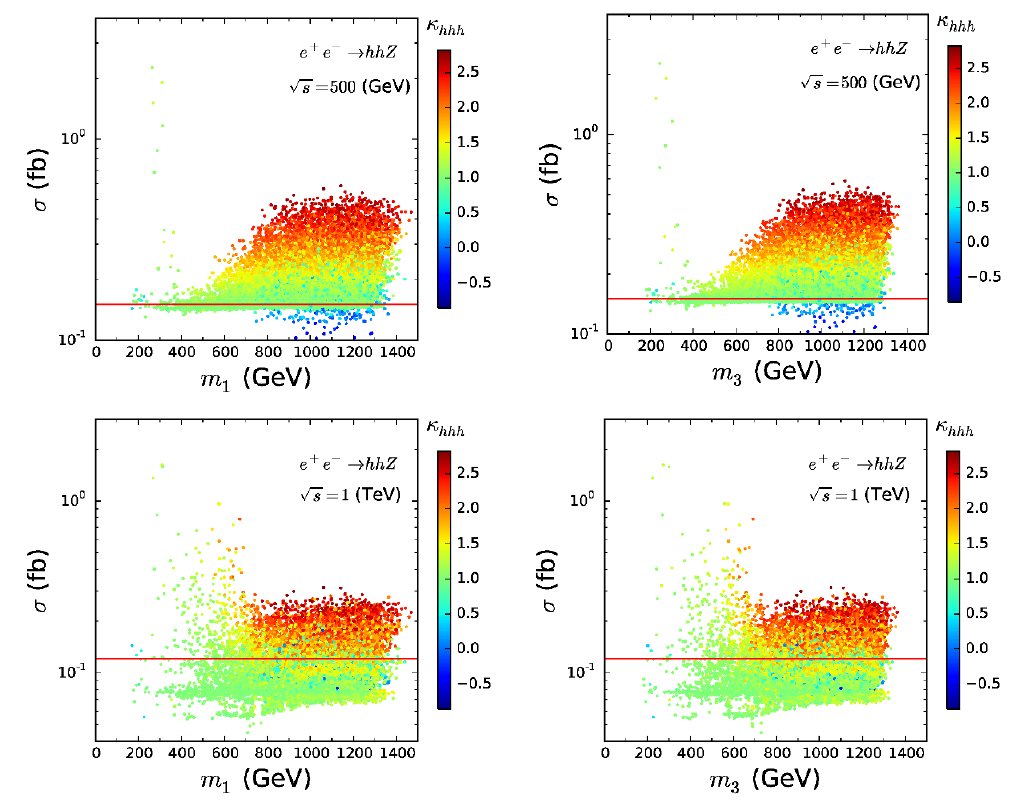
Figure 15 . Cross section for e + e ! hhZ as a function of the H 0 (cid:0) p mass m 3 (right) at s = 500 GeV (upper) and 1 TeV (lower). The horizontal line indicates the SM